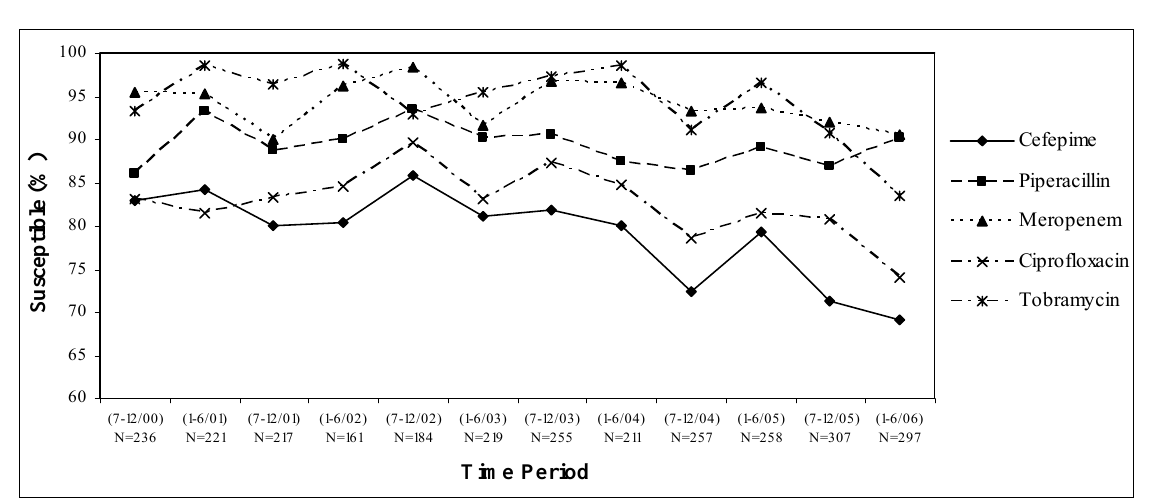
Figure 1. UCDMC antimicrobial susceptibilities of P. aeruginosa : July 2000–June